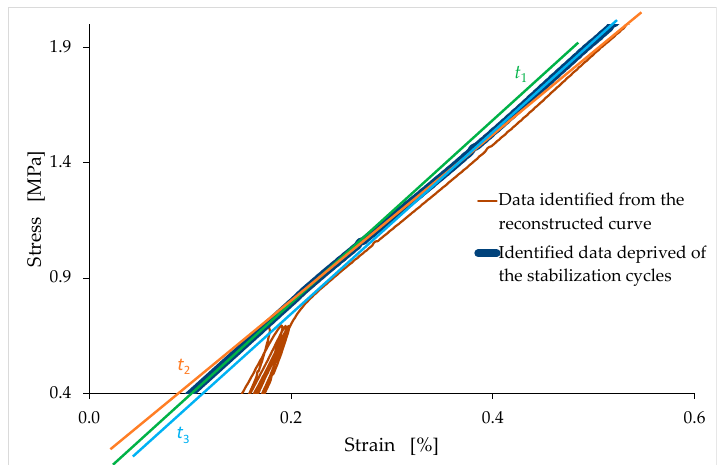
Figure 16. Detail of Figure 9: t 1 is the tangent line at the end of the linear branch; t 2 is the tangent line at the inflection point; and t 3 is the tangent line drawn for a stress value greater than the stress at the inflection point.